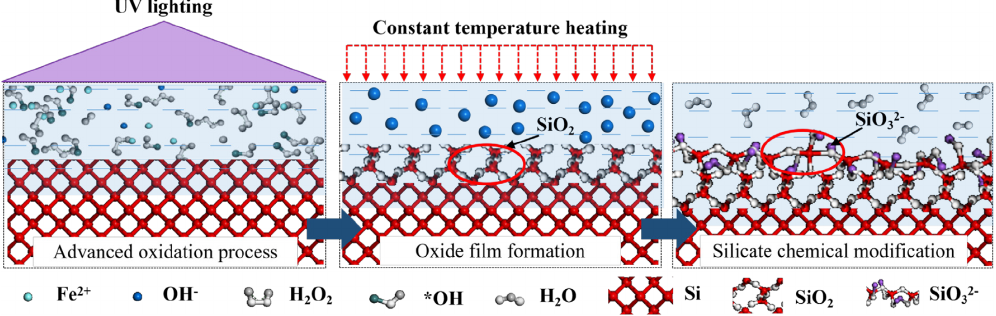
Figure 1. Sketch of UVA-CM for monocrystalline